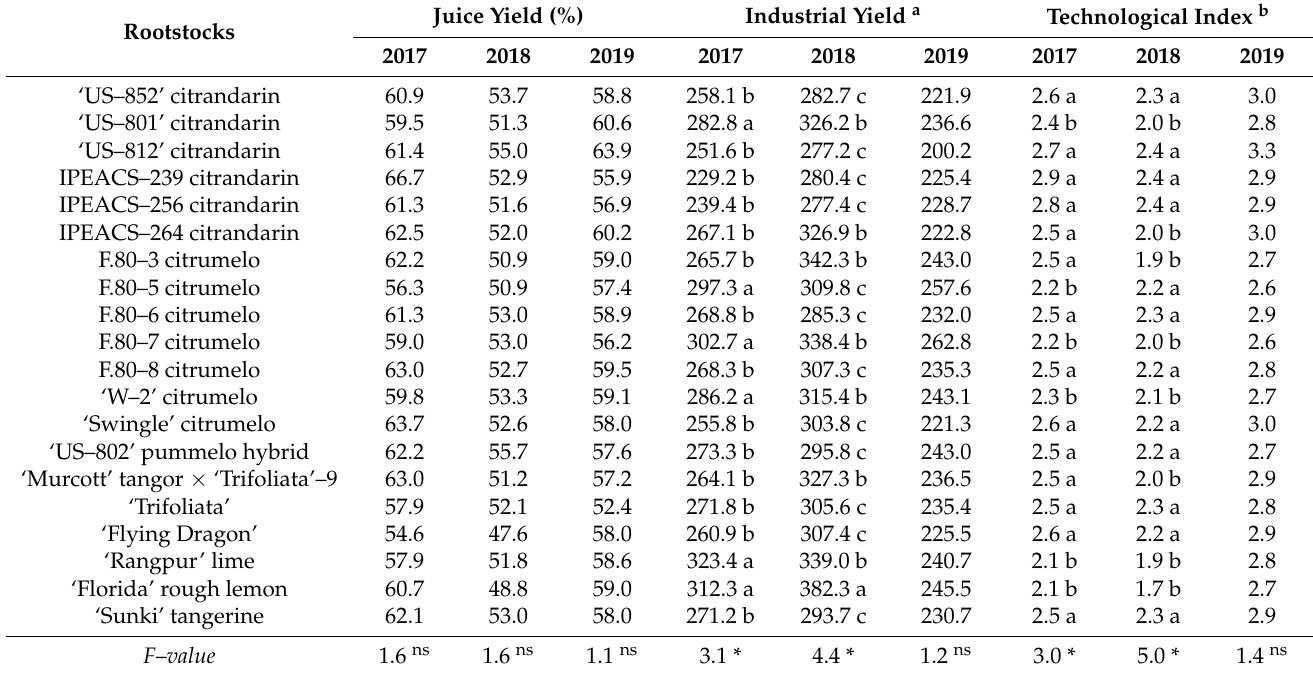
Table 5. Industrial properties of juices of ‘Valencia’ sweet orange trees grafted on 20 rootstocks.